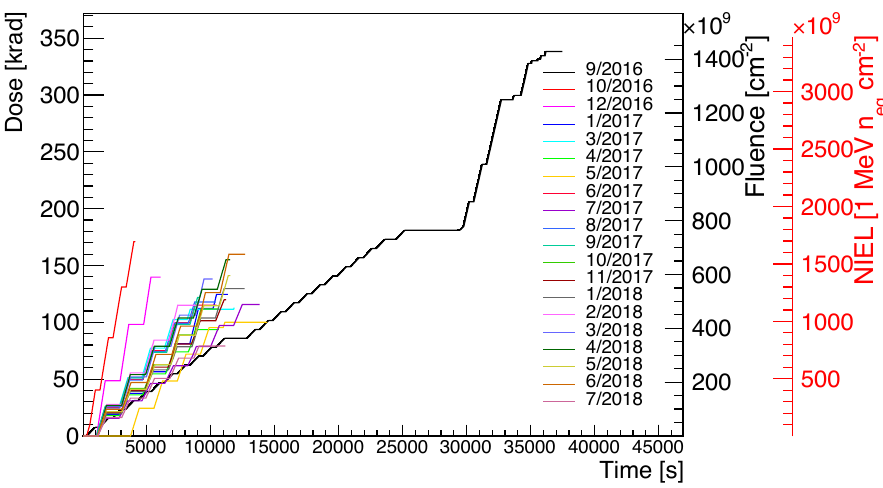
Figure 5. The total ionization dose, the accumulated proton fluence, and the non-ionizing energy loss (NIEL) for different irradiation campaigns. The legend gives the date of the performed